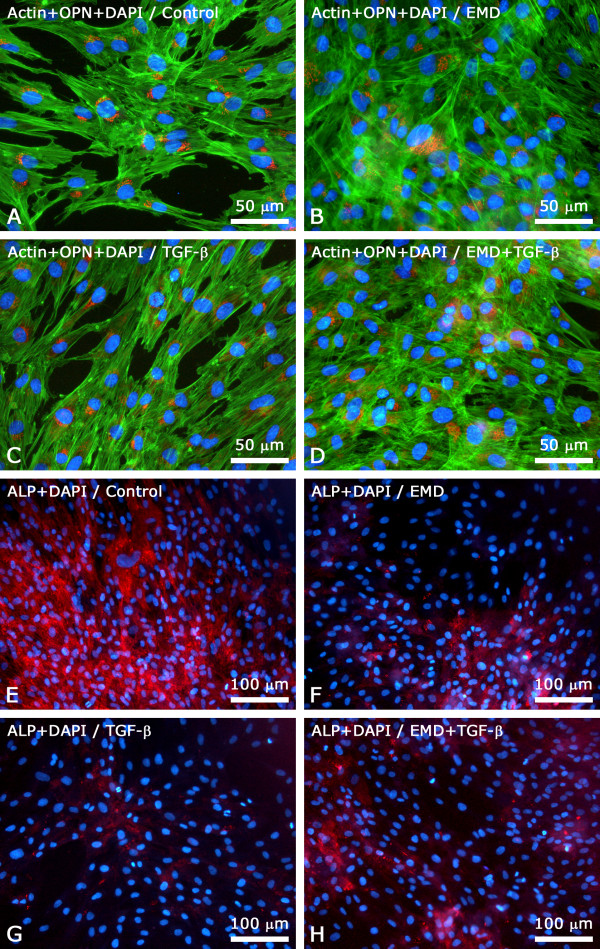
Epifluorescence at day 5 post-treatment with the factors. (A-D) Immunolabeling for osteopontin (OPN, red fluorescence) was mainly cytoplasmic, in perinuclear area and in punctate deposits. Cell-associated green fluorescence reveals actin cytoskeleton (Alexa Fluor 488-conjugated phalloidin), whereas blue fluorescence indicates cell nuclei (DAPI - DNA staining). No major differences were noticed among groups in terms of labeling pattern and fluorescence intensity for OPN. (E-H) Immunolabeling for alkaline phosphatase (ALP, red fluorescence) was more intense for the positive control compared to the treated groups.